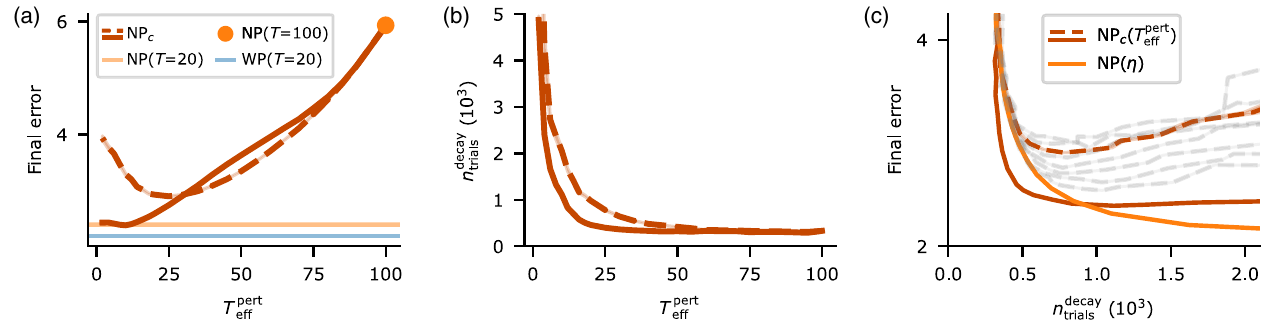
FIG. 4. Temporally correlated perturbations improve NP if the input has similar correlations. (a) Final error of NPc versus the effective time dimension T pert of its perturbations; smaller T pert means smoother perturbations. The inputs are constructed with T input ¼ 20 (red eff eff eff continuous line) or T input ¼ 100 (uncorrelated, red dashed line). The final error of NPc decreases compared to that of NP (orange dot) for eff ≤ T input < T ¼ 100 . For correlated inputs and T pert T pert ¼ 20 , NPc ’ s final error reaches that of NP in a reduced task with T ¼ 20 eff eff eff (orange line; WP, blue line); for uncorrelated inputs and small T pert , it increases again. This increase is not caused by lack of eff . convergence. (b) Convergence time, measured as the number of trials until 95% of the final error correction is reached, versus T pert eff < T input . The Learning gets considerably slower if the correlation times of the perturbation are longer than those of the input, i.e., T pert eff eff same curve markings as in (a). (c) Simultaneous plot of error and convergence time of NPc [red line, data as in (a) and (b) for correlated (solid line) or uncorrelated input (dashed line); thus, curves are obtained by varying T pert ; faint gray line, curves for uncorrelated input eff with different learning rates η ] and NP (orange, curves obtained by varying the learning rate η ). For correlated inputs and similarly correlated perturbations, NPc yields a true improvement over NP: It has simultaneously a smaller error and smaller convergence time. > 1000 ). NP For considerably longer correlation times, the final error saturates, but the convergence time increases (region with n decay trials with reduced learning rate η there yields a smaller final error at the same convergence time. For uncorrelated input, NPc does not yield a true improvement. In particular, the smaller final error (a) can be achieved at smaller convergence times by NP with reduced η , even if 0 . 04 , E 2 , M ¼ 10 , N ¼ T ¼ 100 , σ NPc is allowed to additionally adapt its learning rate (gray curves). Parameters: N eff ¼ eff ¼ opt ¼ and 20000 trials. (a),(b) Mean and standard error of the mean (SEM, partly occluded). (c) Mean values and SEM of final error (red and orange lines). In gray curves, η is modified relative to the red curve by a factor ranging from 0.5 (lowest curve) to 1.2 (highest curve) in steps of